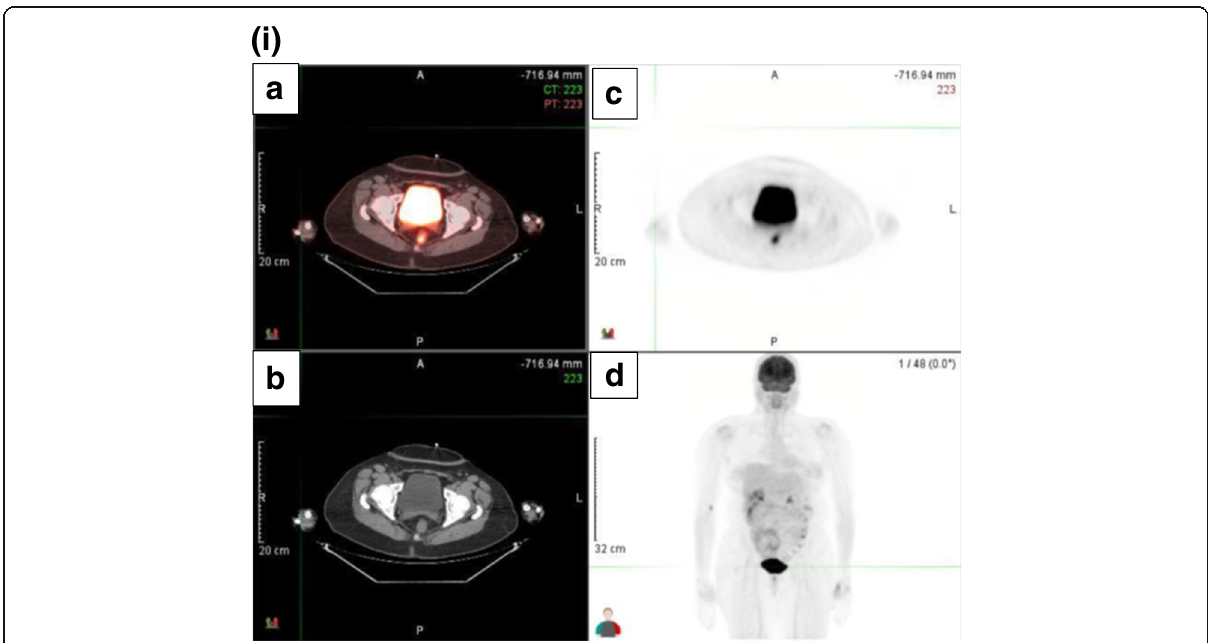
Fig. 3 A 55-year-old female. ( i ) Physiological mild nonfocal rectal activity. SUVmax 5.9, pathologically proved a false +ve case. a Axial PET/CT. b Axial CT. c , d